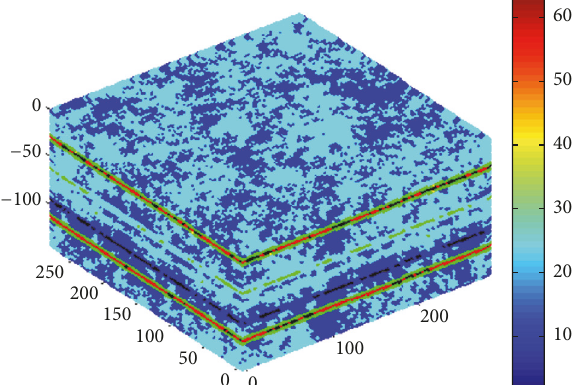
Figure 1: Effective porosity distribution in 2 Hm-scale simulation of the MWX crustal volume transected by a vertical wellbore. The colour-bar codes the degree of porosity in the section. Cool colours denote the 3D ambient distribution of spatially correlated porosity in accord with spatial fluctuation power-law spectral scaling (5) for well-log porosity range 0.1 < 𝜑 < 0.3. Warm colours denote elevatedeffectiveporositywithelevatedporoconnectivityparameter 𝛼 controlling permeability via (7). These layers represent crustal faults that intersect the transecting wellbore at depths recording spikes in neutron porosity